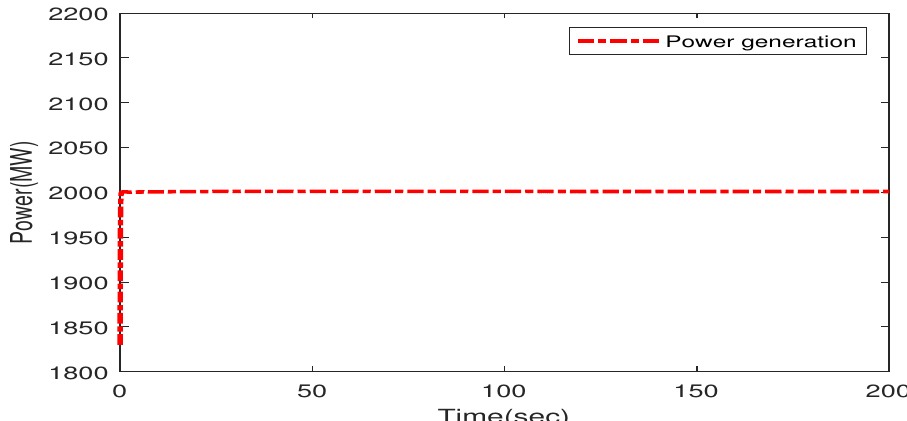
Figure 6. Total active power output using improved consensus protocol considering capacity constraint.